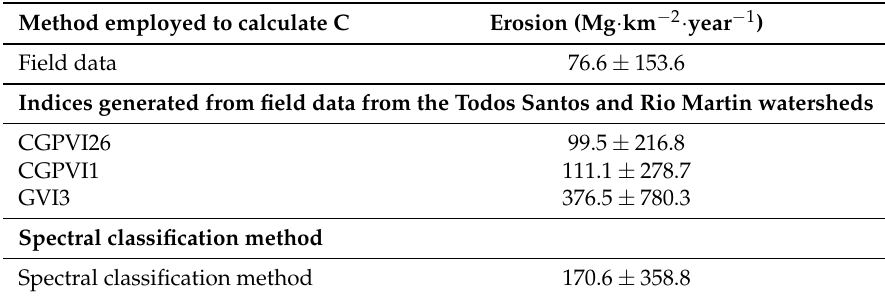
Table 7. Average and standard deviation for the erosion rate from the sampling points for the training set. Each row shows a different method to calculate C